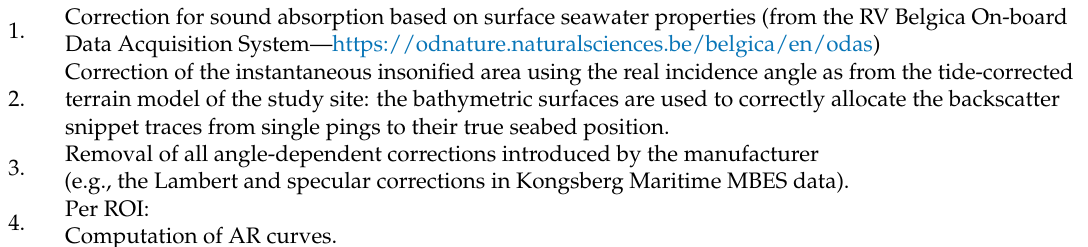
Table 4. Backscatter processing steps after [30] for the AR time-series dataset ( SonarScope © processing).